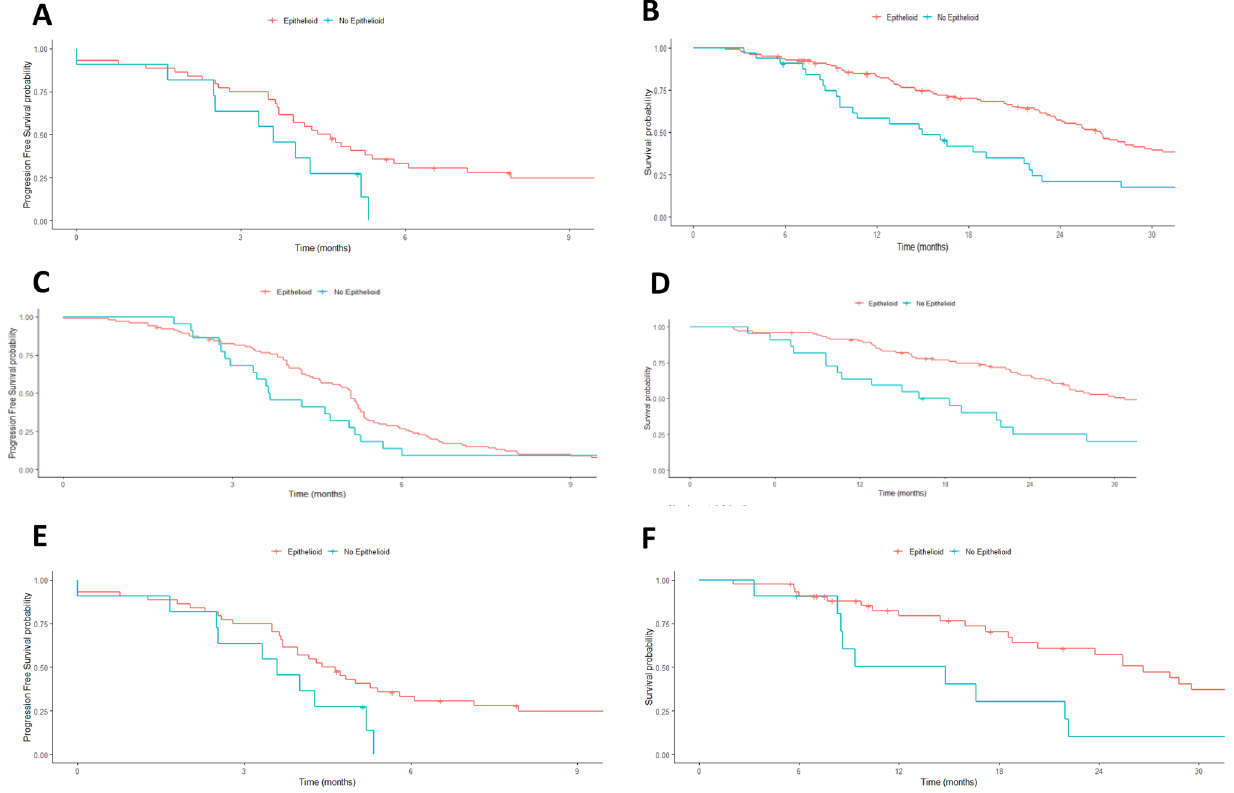
Figure 3. Kaplan–Meier overall survival according to histology: PFS and OS of patients treated with first line chemotherapy ( A , B ), PFS and OS of patients treated with cisplatin ( C , D ) and PFS and OS of patients treated with carboplatin ( E , F